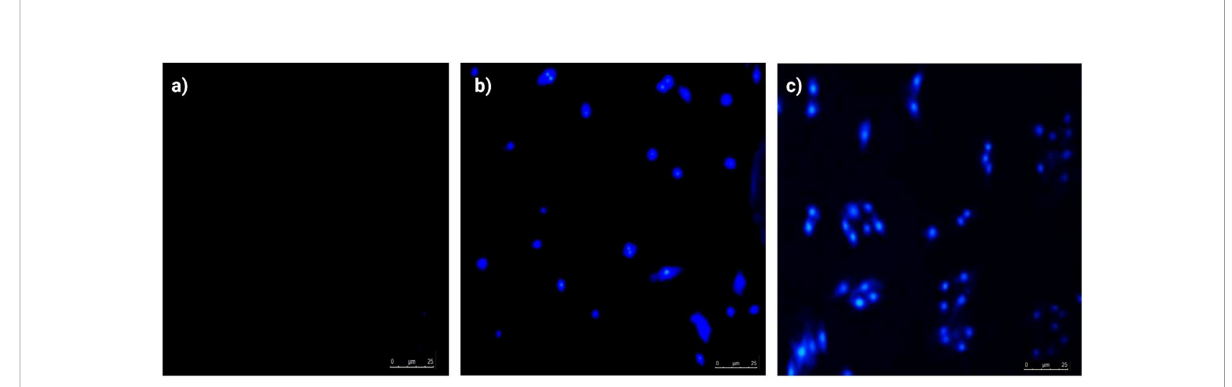
FIGURE 3 Apoptotic morphological evaluation of SK-BR-3 cells by DAPI staining (inverted fl uorescence microscopy, 200x). (A) Control group, Healthy SK-BR-3 cancerous cells without blue fl uorescence, (B) Treatment with ethyl acetate extract of Spirastrella pachyspira (10 m g/ml) and (C) Treatment with ethyl acetate extract of Spirastrella pachyspira (30 m g/ml), showed condensed and fragmented apoptotic bodies with blue fl uorescence and nuclear or chromatin condensation.